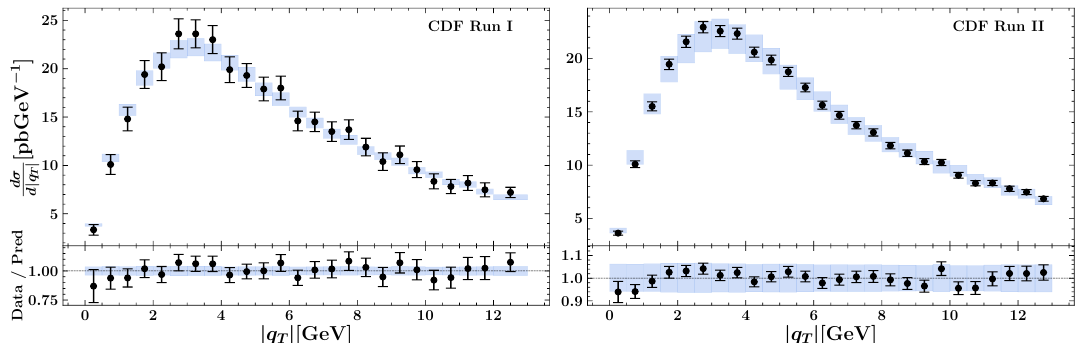
Figure 9 . Upper panels: comparison between experimental data and theoretical predictions for the cross section differential in for Z bosons produced in p ¯ p collisions at the Tevatron from q T | | CDF Run I (left panel) and run II (right panel); uncertainty bands correspond to the 68% CL. Lower panel: ratio between experimental data and theoretical